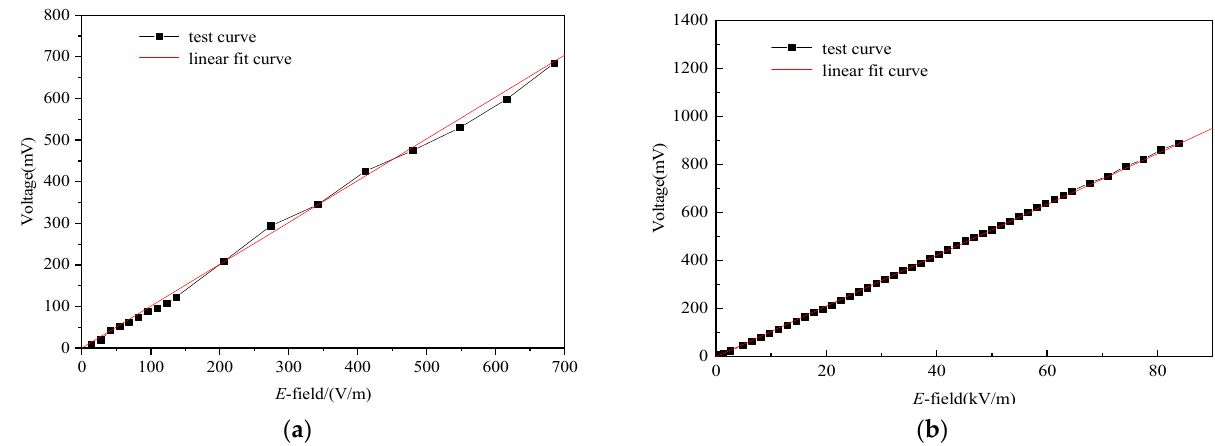
Figure 15. The relationship between the electric field and output voltage of the weak field sensor ( a ) and the strong field sensor ( b